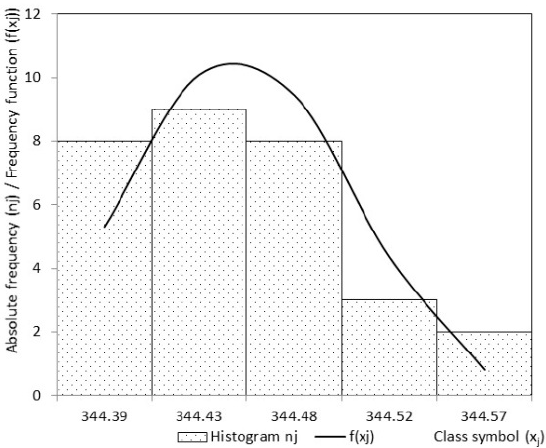
Figure 17. Histogram and the frequency function for the length parameter, second day. After a positive finding of a normal distribution, it is necessary to verify the stability of the process. The constructed control chart for the sliding ranges (Figure 18) does not indicate any problem, though point 16 is at the lower control